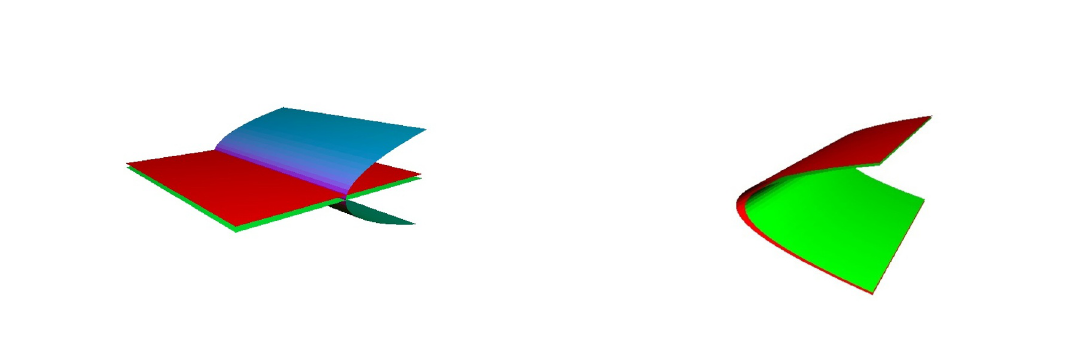
Figure 8 . Yukawa couplings are coming from the intersection of the matter curves of V and Λ 2 V .